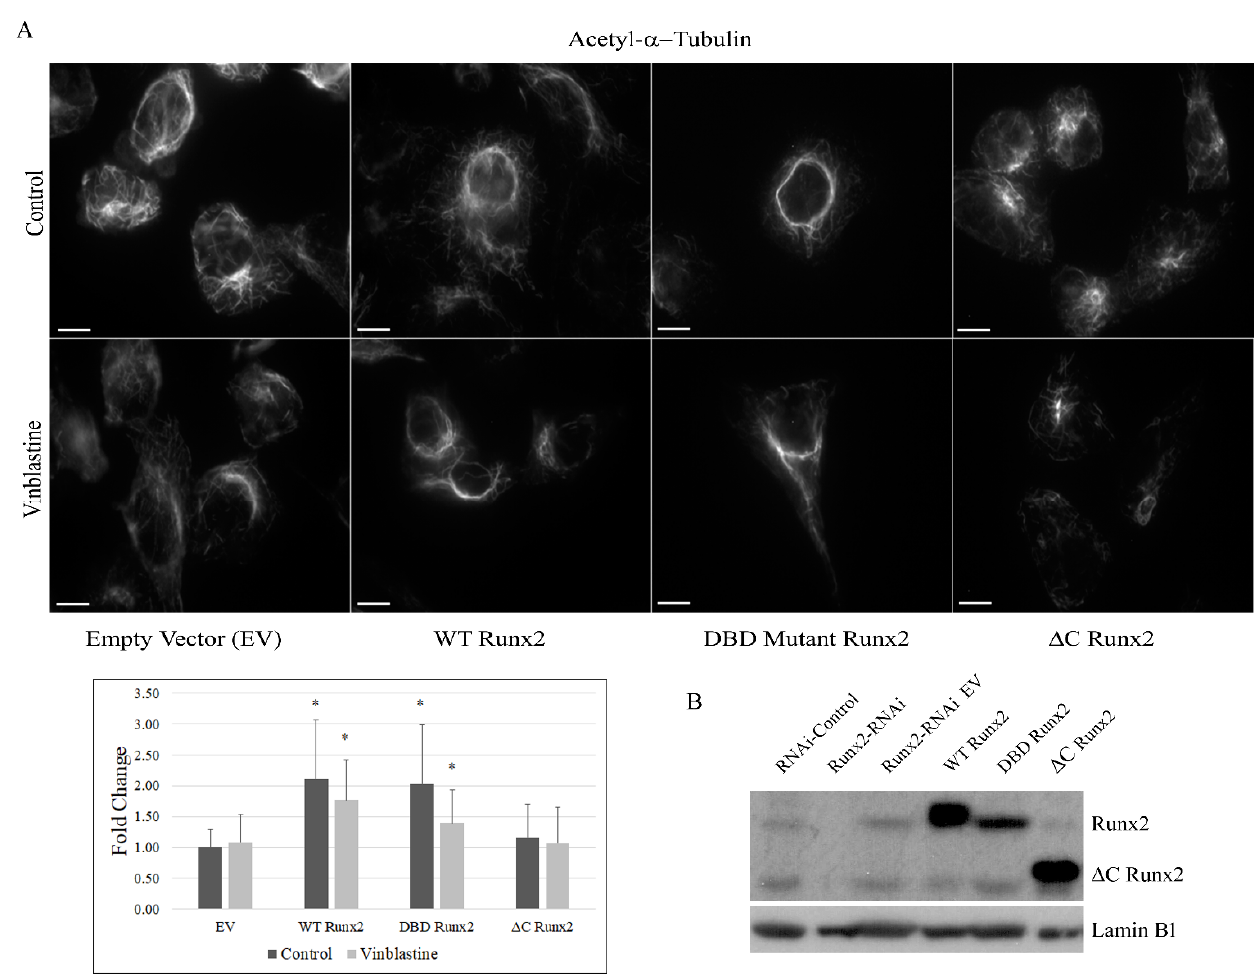
Figure 5. Runx2 C-terminal is critical for acetyl- α -tubulin levels. ( A ) Bone-derived MDA-MB-231 cells transduced with lentiviral constructs containing either empty vector (EV), wild-type Runx2, DNA binding domain mutant Runx2 (DBD Runx2), or C-terminal deletion Runx2 ( ∆ C-Runx2). Transduced cells were seeded overnight and were treated in the presence and absence of 1 mM vinblastine for 5 min. Cells were fixed and stained for acetyl-α-tubulin (Lys40) and imaged. Thirty cells per group were randomly selected and quantified for acetyl-α-tubulin signal intensity using ImageJ. Results were analyzed via unpaired t-test with comparison relative to corresponding EV control * p ≤ 0.05. Representative 100X images are shown. ( B ) Western blot analysis for Runx2 expression in nuclear lysates from the transduced cells. Lamin B1 levels were used as loading